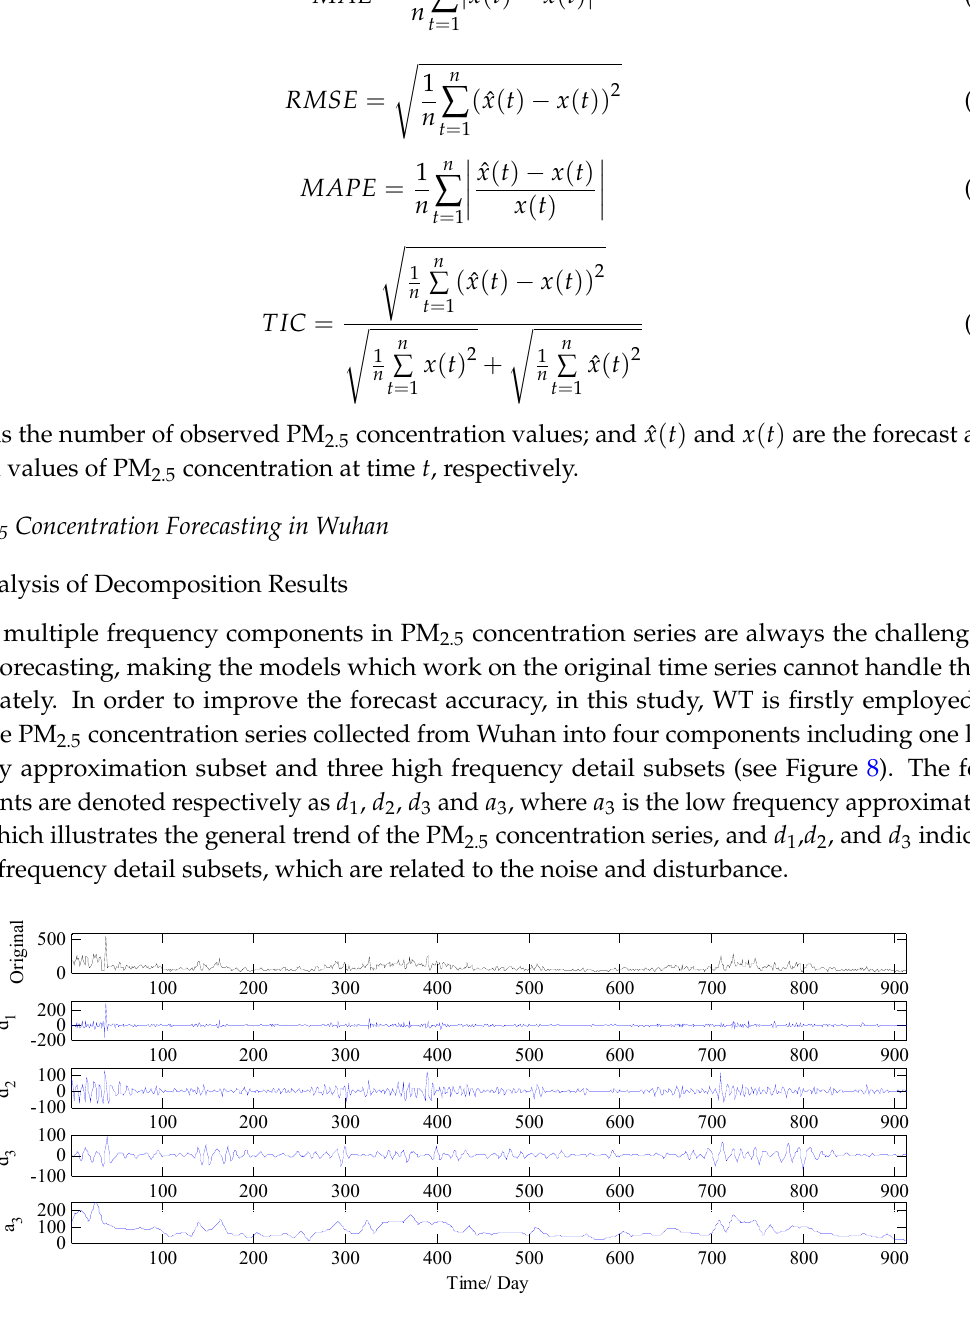
Figure 8. Decomposition results of PM 2.5 concentration series by WT (Wuhan).